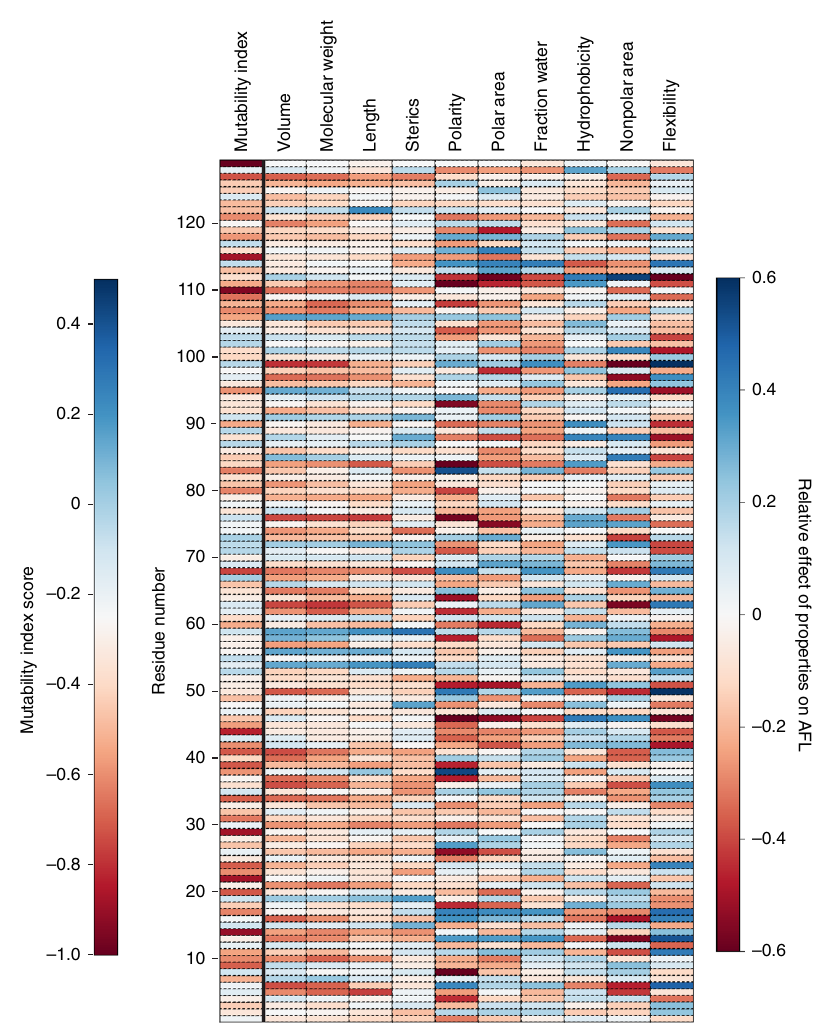
Fig. 5 The effect of physical properties on the apparent fi tness landscape (AFL). Each value represents the sum of the apparent fi tness score (AFS) multiplied by a scalar corresponding to the indicated property. Blue scores mean that the position showed a preference for high property values, while red scores show a preference against high property values. Mutability index is shown as a